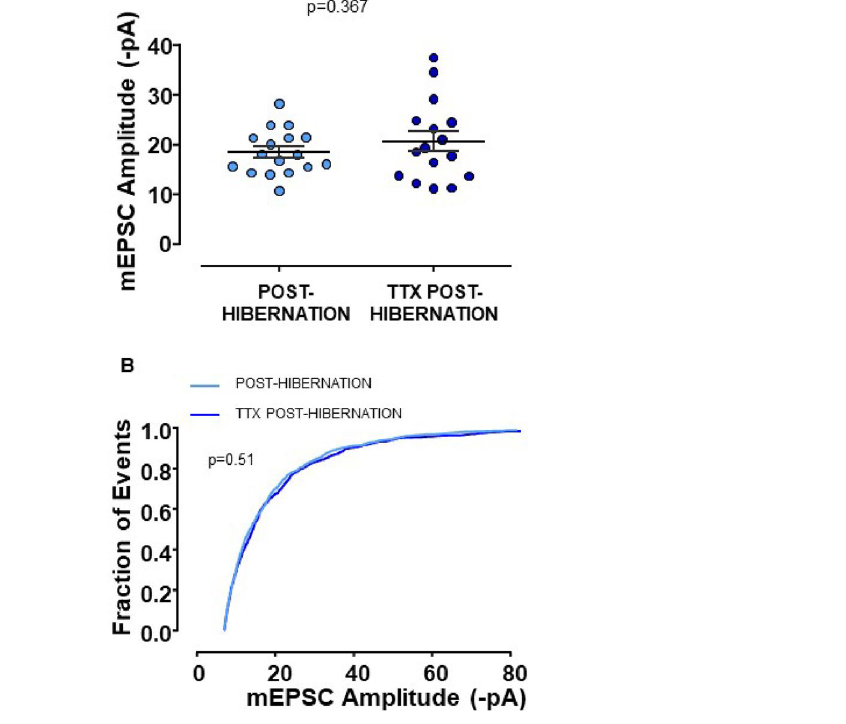
Figure 3. Hibernation occludes the mEPSC amplitude increase by TTX. ( A ) The mean mEPSC amplitude after hibernation and hibernation in the presence of 16 h TTX (unpaired t -test). Post-hibernation, n = 17 from 4 animals and TTX Post-hibernation n = 16 from 4 animals. ( B ) The cumulative distribution of post-hibernation and TTX post-hibernation mEPSC amplitudes (p-value from Kolmogorov–Smirnov Test). Circles represent data points for individual neurons, and average values are indicated by the horizontal line. Error bars are